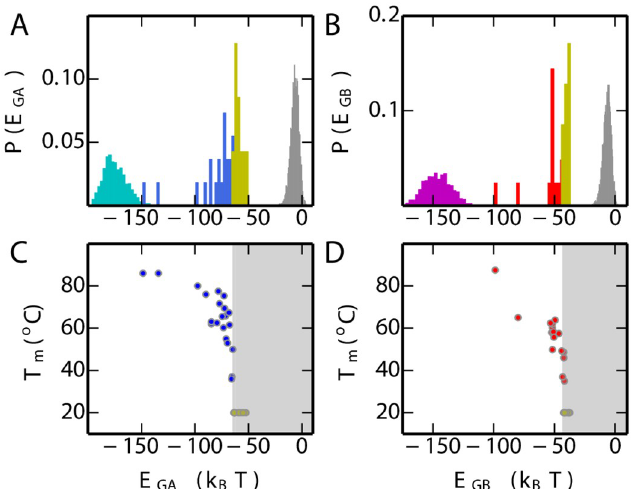
Fig 2. Properties of the single-fold models. (A) Distribution of E GA for the GA homologs used to parameterize E GA (cyan), synthetic sequences which are dominated by GA fold (blue) state in equilibrium, unstable synthetic sequences (yellow) and randomly generated sequences (grey). (B) Distribution of E GB for the GB homologs used to parameterize E GB (purple), synthetic sequences which are dominated by GB fold (red) state in equilibrium, unstable synthetic sequences (yellow) and random sequences (grey). (C) The correlation between the folding temperature ( T ) and E GA m for synthetic sequences of GA. Stable mutants are blue symbols, unstable are yellow symbols with T m set to 20˚C for plotting purposes. (D) The correlation between T and E GB for experimental mutants of GB (stable: red, unstable: m yellow, T set to m